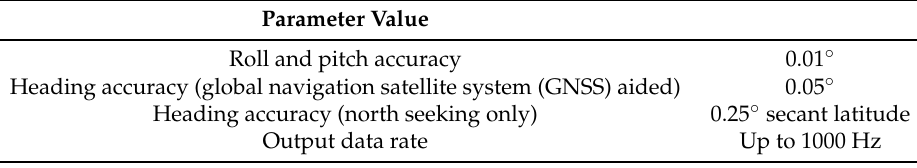
Table 1. Specification of fibre optic gyroscope (FOG) used in experiment 1 to provide reference attitude for comparison.